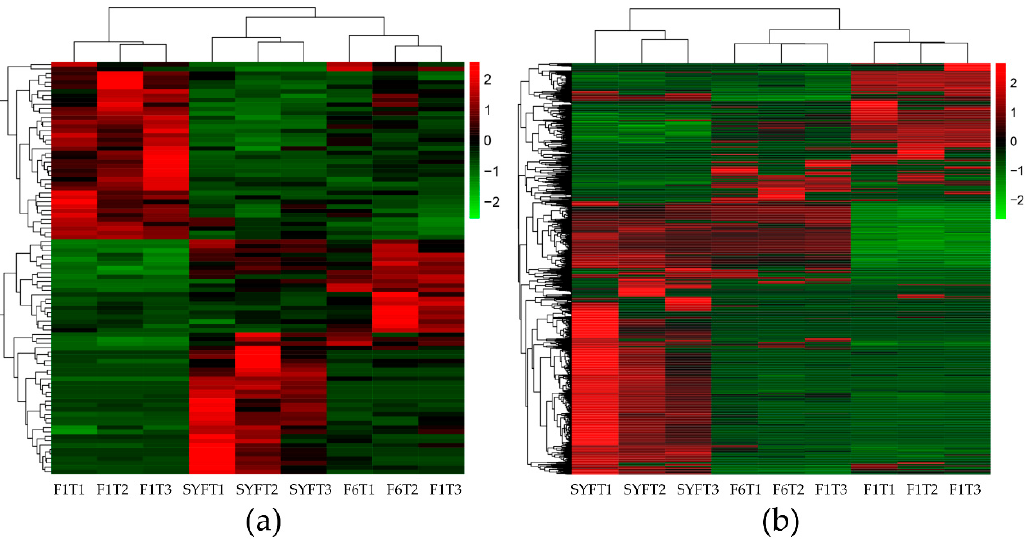
Figure 2. Heatmap of expression profiles for the differentially expressed circRNAs ( a ) and mRNAs ( b ). Each column displays one sample, and each row represents a circRNA or a mRNA. SYF: small yellow follicle, F6: smallest hierarchical follicle, F1: largest hierarchical follicle. T: theca cells.